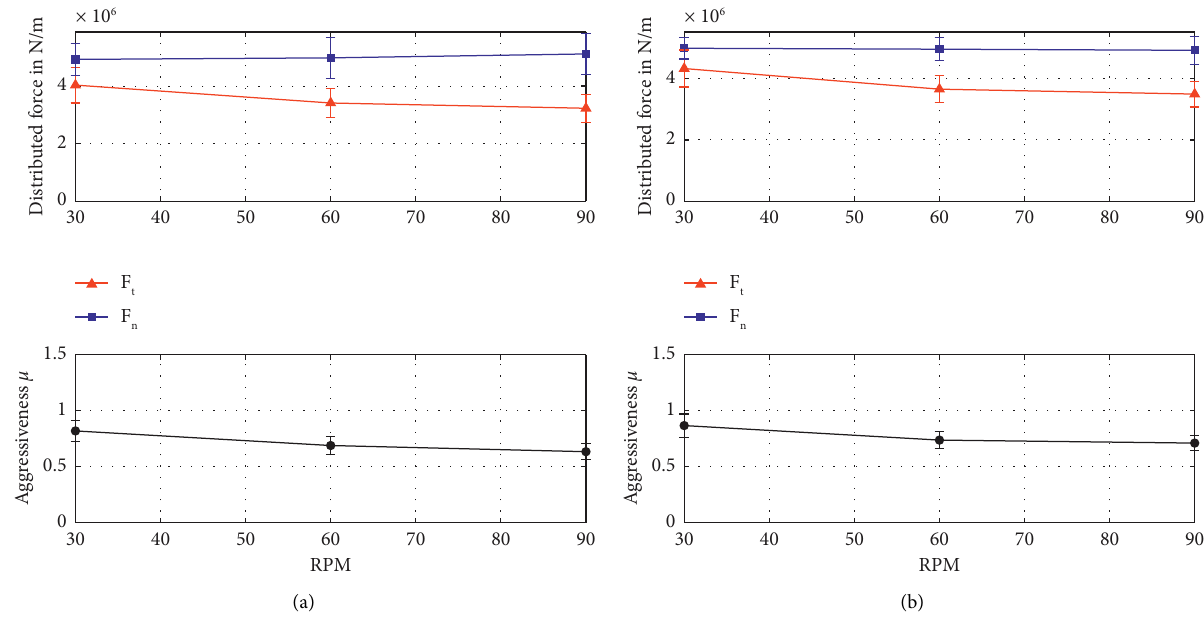
Figure 15: Averaged forces and aggressiveness at various cutting speeds under constant axial force control using models with rate- dependent (a) normal bond strength and (b) grain elastoplasticity.